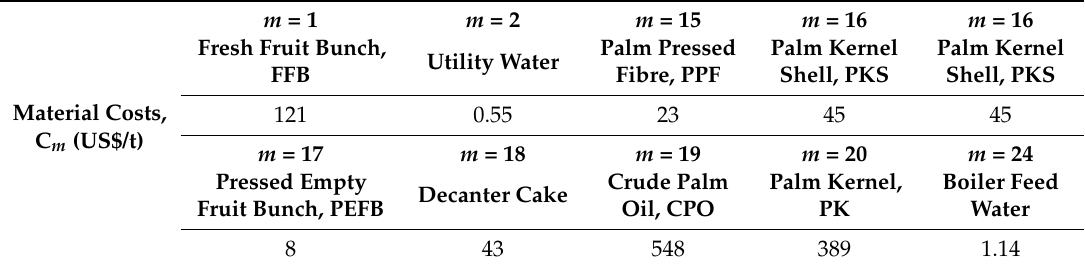
Table 7. Material costs, C m for palm oil milling